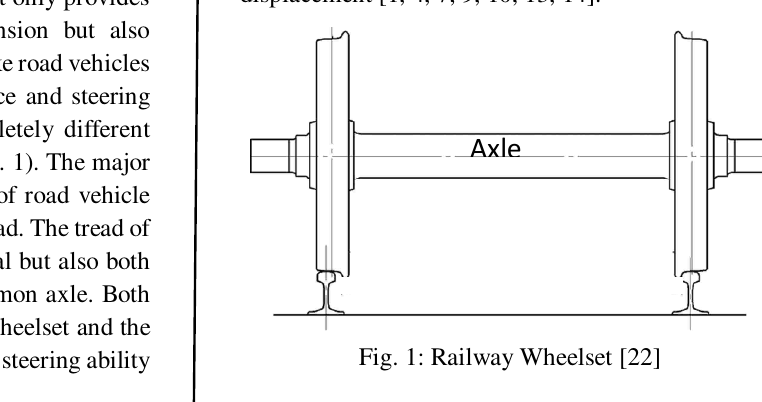
Fig. 1: Railway Wheelset [22]